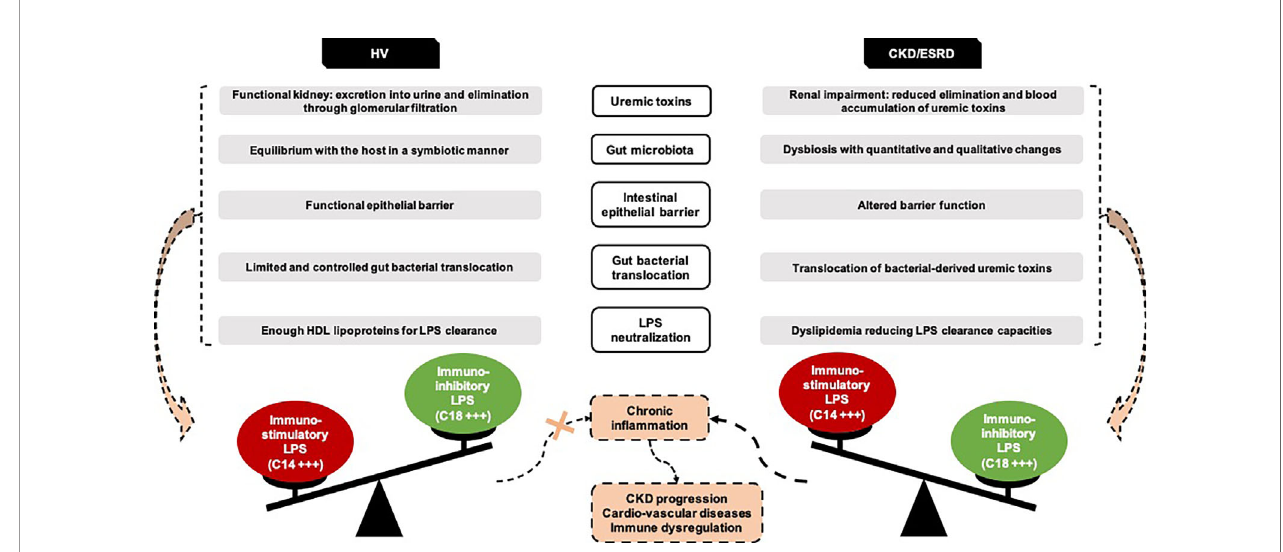
FIGURE 7 | New insights on ESRD and HV gut bacterial translocation. Representation of the hypotheses emerging from the GABII cohort study. CKD, Chronic Kidney Disease; ESRD, End-Stage Renal Disease; HV, Healthy